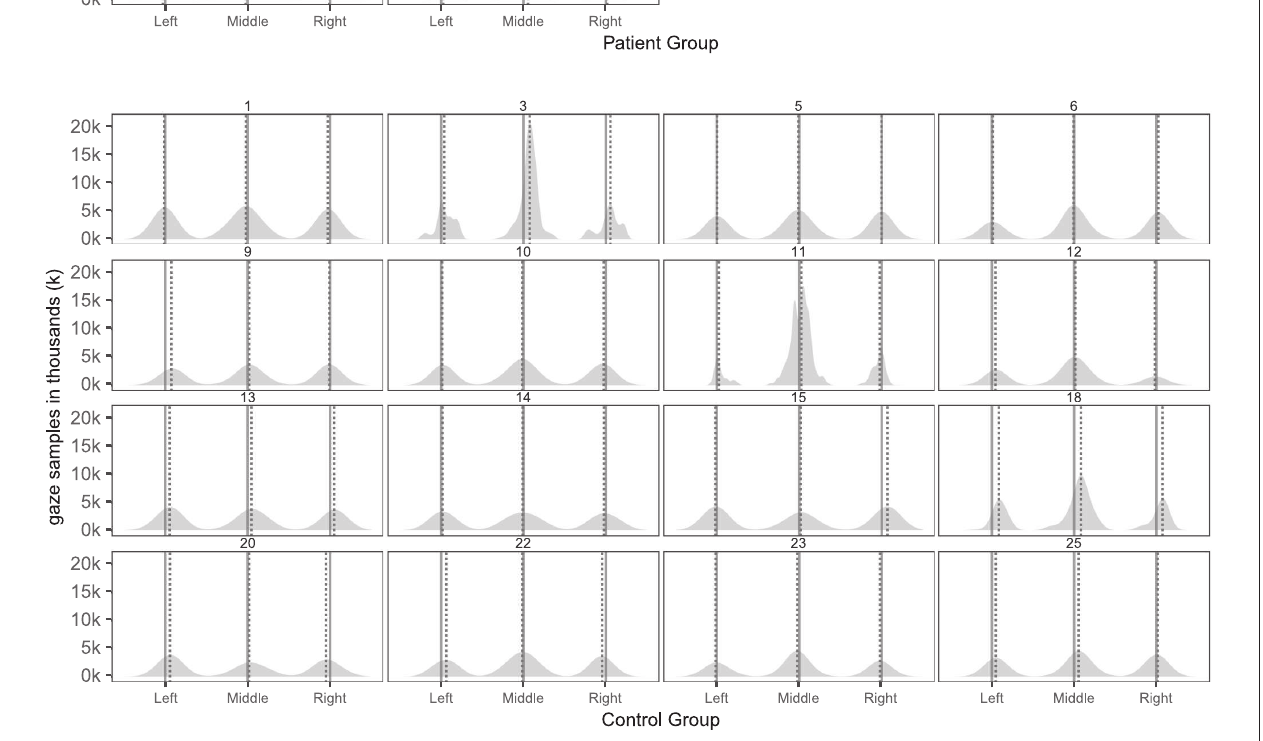
FIGURE 3 | Individual spatial distributions of gaze samples on the three pictures with true picture midline (solid lines) and median gaze (dotted lines) of patients and controls. The x -axis reports the horizontal axis of the virtual museum scene. The y -axis counts the number of gaze samples in thousands (k).